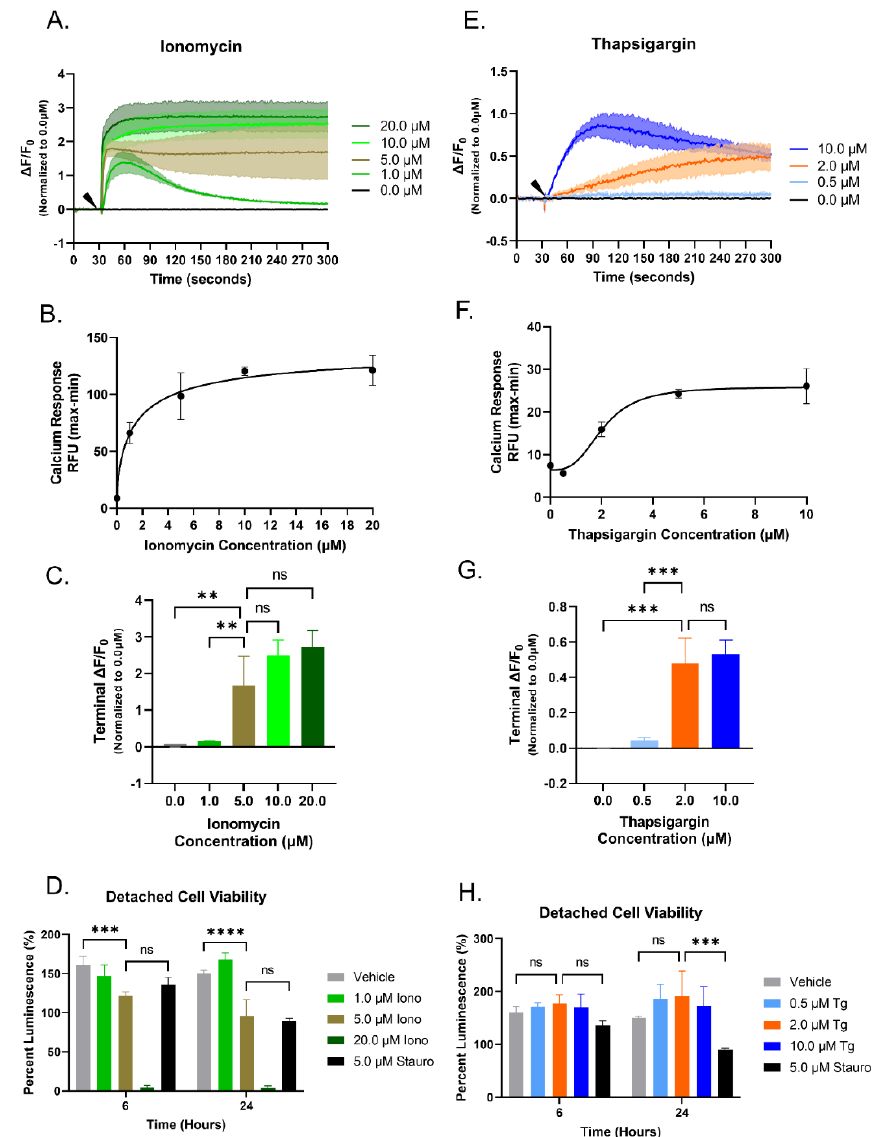
Figure 2. Ionomycin and Thapsigargin induce an elevation of cytoplasmic Ca 2+ in a dose-dependent manner in MDA-MB-436 cells. ( A – C , E – G ) After a 30 s basal recording of fluorescence (Ex494 nm; Em: 516 nm), an arrow indicates the increasing concentrations of Iono or Tg that were added and continually recorded for an additional 270 s. Relative fluorescence unit (RFU) data was analyzed in GraphPad Prism and presented as change in RFU divided by the initial RFU (ΔF/F 0 ). Data shown are mean ± SD and representative of 3 independent experiments performed in triplicate. ( A ) Traces of increasing cytoplasmic Ca 2+ (ΔF/F 0 ) of MDA-MB-436 cells in response to the addition of increasing concentrations of Iono. ( B ) EC50 Ca 2+ response curve (RFU) for increasing concentrations of Iono. ( C ) Terminal ΔF/F 0 value for each concentration of Iono used. ( D ) MDA-MB-436 cell viability in a suspended state with different concentrations of Iono treatment over a 24 h time course. ( E ) Increasing cytoplasmic Ca 2+ response (ΔF/F 0 ) traces to the addition of increasing Tg concentrations. ( F ) EC50 Ca 2+ response curve (RFU) of MDA-MB-436 cells for increasing concentrations of Tg. ( G ) Terminal ΔF/F 0 value for each concentration of Tg. ( H ) Cell viability of MDA-MB-436 cells in suspension with increasing concentrations of Tg treatment over 6- and 24- hour treatment. ( D , H ) Data shown are mean ± SD and representative of 3 independent experiments performed in triplicate. n.s., ** p < 0.01, *** p < 0.001 and **** p < 0.0001.